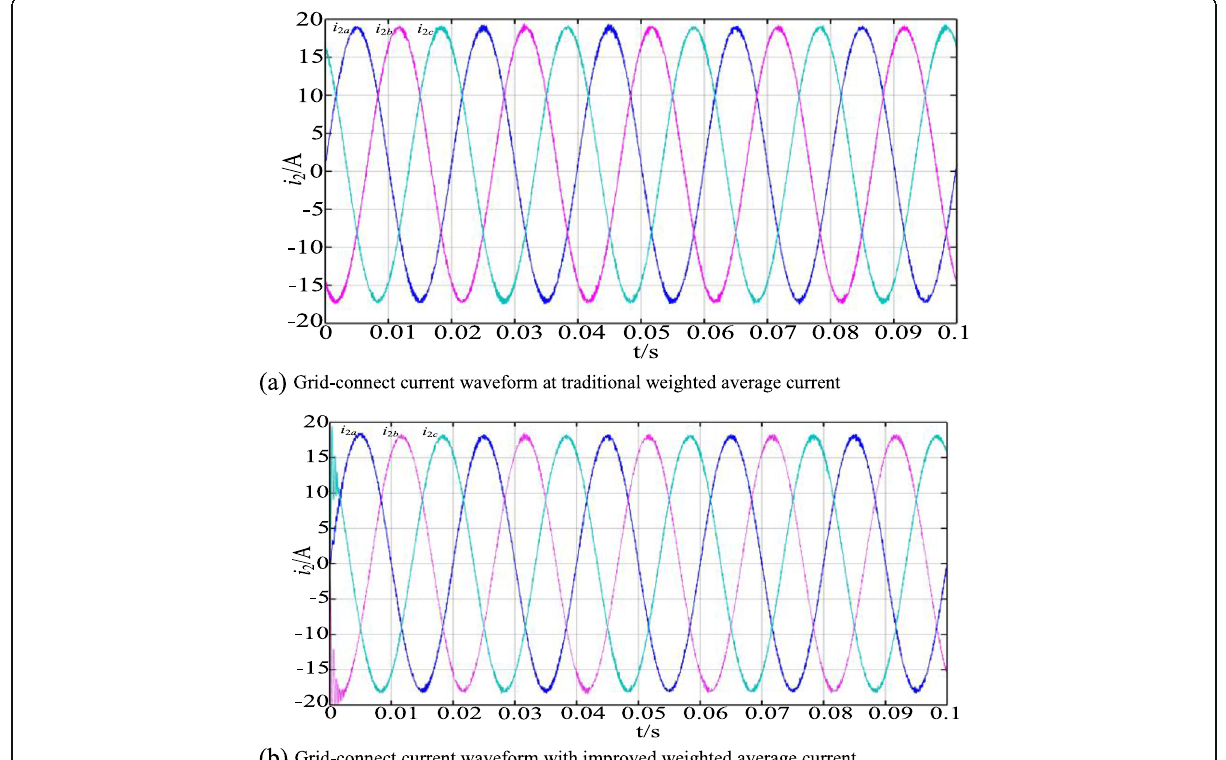
Fig. 10 Grid-connect current waveform at Lg = 0 mH. a Grid-connect current waveform at traditional weighted average current. b Grid-connect current waveform with improved weighted average